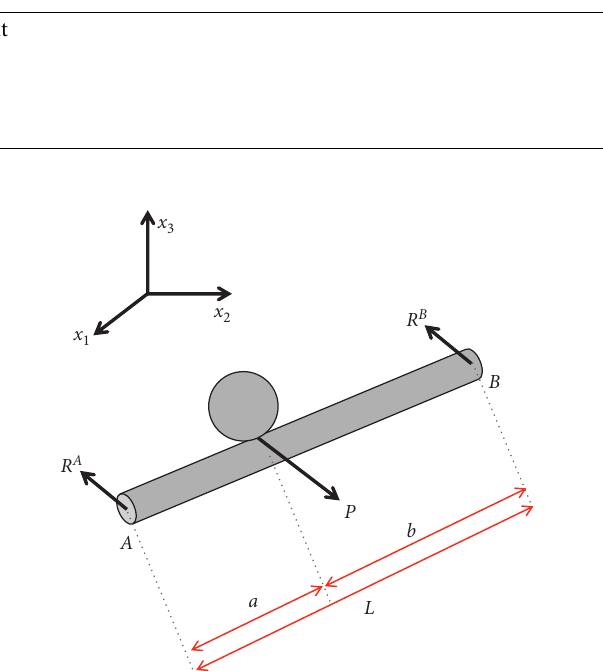
Figure 4: Schematic of contact algorithm between DEM and